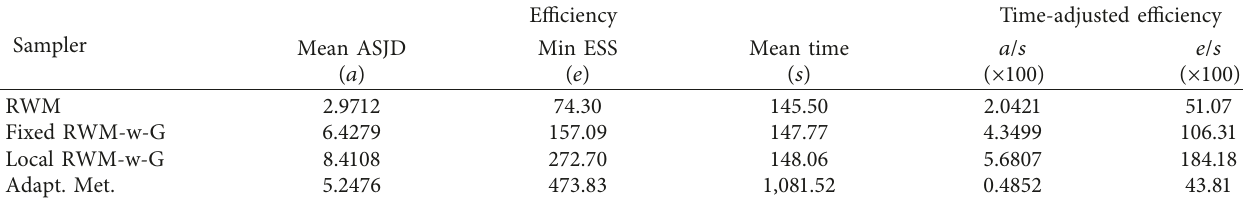
Adapt. Table 3: Stochastic volatility : efficiency and time-adjusted efficiency measures for the four samplers tested. Sampler